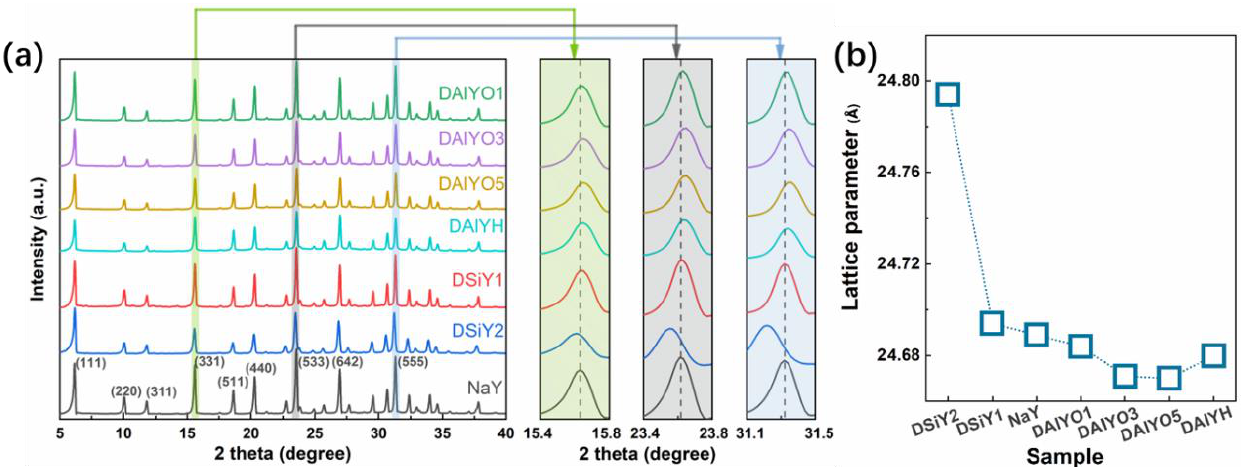
Figure 1. XRD patterns of NaY, DSiY1, DSiY2, DAlYO1, DAlYO3, DAlYO5, and DAlYH, ( a ), and the corresponding calculated unit cell parameters ( b ). The diffraction peaks of the parent NaY zeolite were indexed according to standard PDF#43-0168.